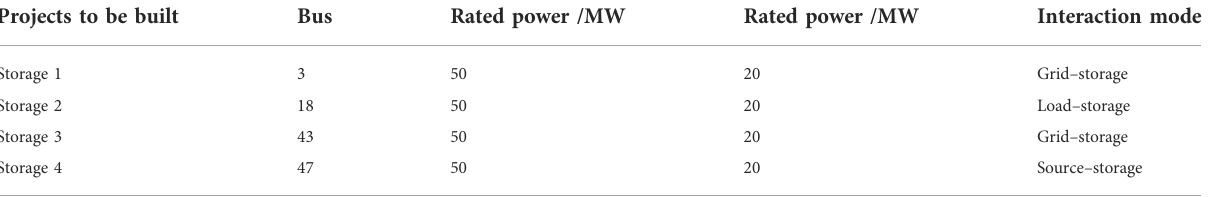
TABLE 4 Basic data of projects to be built on the storage side. Projects to be